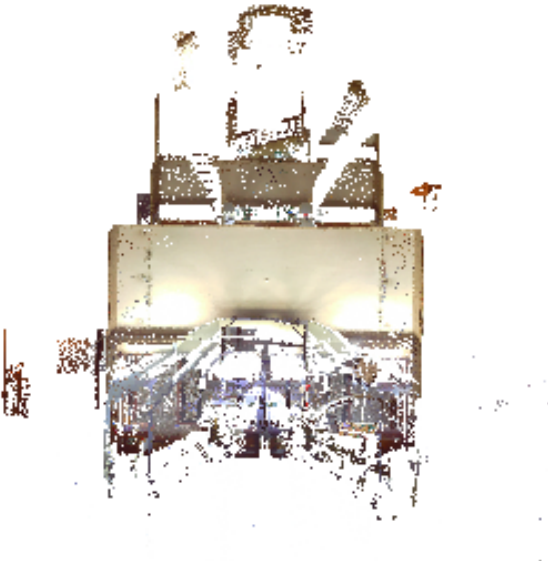
Figure 2. Indoor scan acquired in static mode inside the Zoological Museum of Strasbourg.